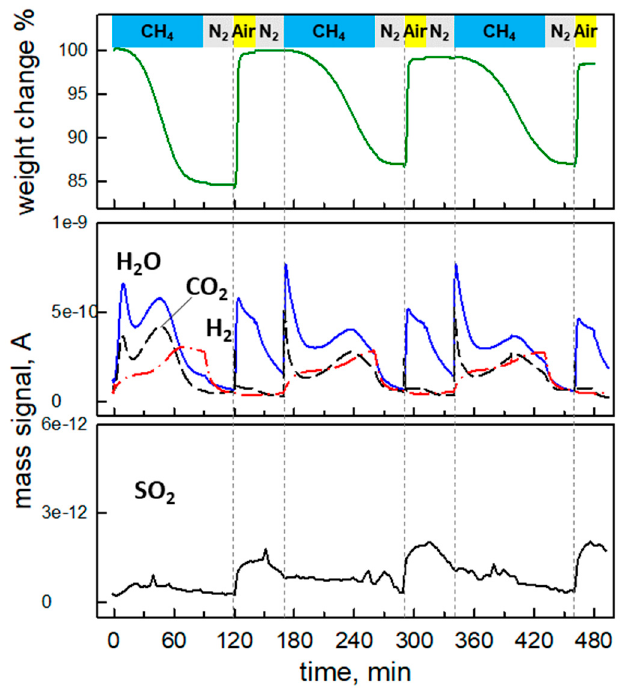
Figure 10. Weight change and gas concentration profiles during chemical looping reactions under cycled feed stream of 5% CH 4 /N 2 and air at 750 °C over Co-La 2 O 2 SO 4 .